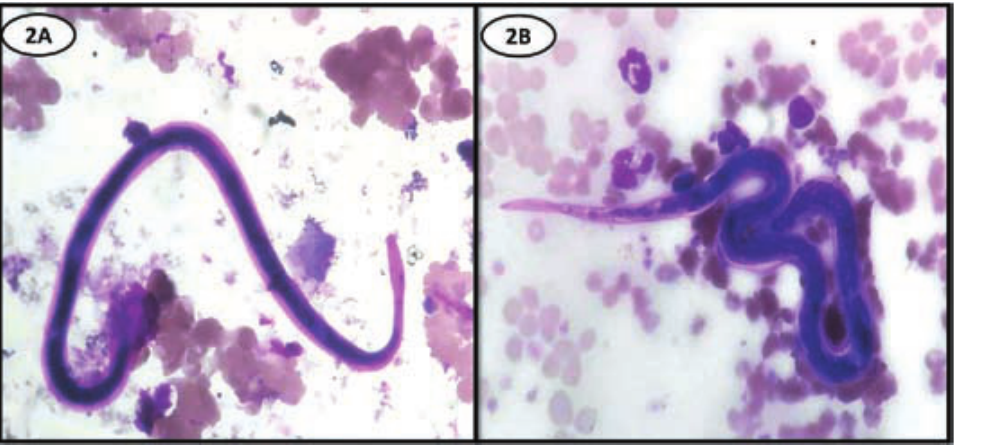
Fig 2A: Presence of sheathed microfilaria in the fine needle aspirate of edematous limb; 2B: Presence of sheath and two distinct widely separated terminal nuclei of the microfilaria in the blood smear may be